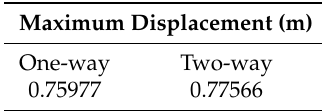
Table 2. Maximum displacement of the